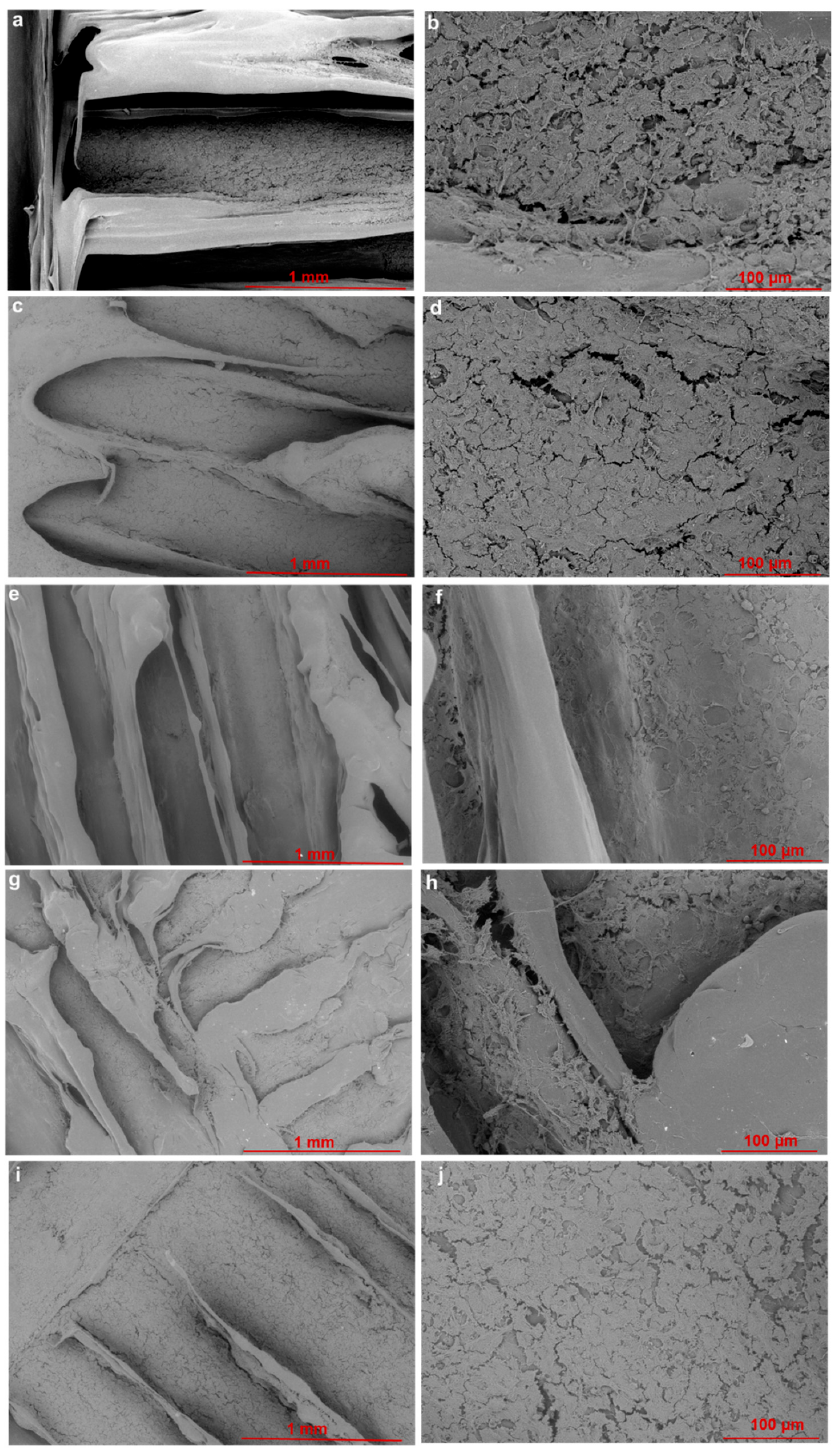
Figure 8. FESEM images taken from one random location for HL-1 cells exposed to PCL and PCL+G scaffolds cultured under standard conditions for 3 days at (i) 50× maginification: ( a ) PCL, ( c ) PCL+0.75G, ( e ) PCL+1.5G, ( g ) PCL+3G, and ( i ) PCL+6G, and at (ii) 300× magnification: ( b ) PCL, ( d ) PCL+0.75G, ( f ) PCL+1.5G, ( h ) PCL+3G, and ( j ) PCL+6G. SEM images were acquired at an acceleration voltage of 5 kV, under a low vacuum of 60 Pa combined with the backscattered electron detector, using a nominal spot size of 30 nm. Scale bar represents a 1 mm distance within the image ( a , c , e , g , i ) and 100 µm distance within the images ( b , d , f , h , j ).